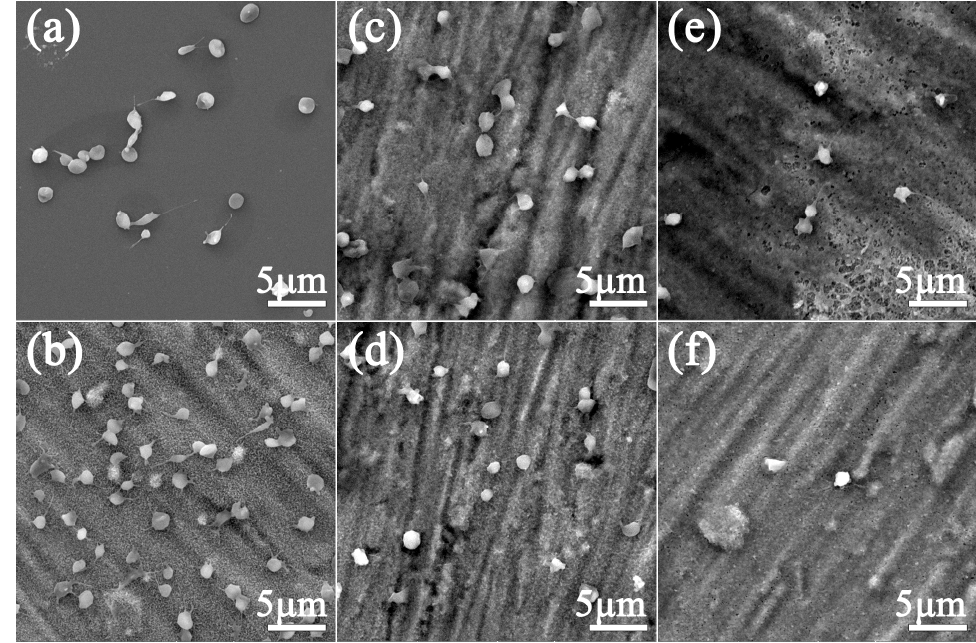
Figure 6. Typical SEM images of platelet adhesion on the surfaces of ( a ) glass, ( b ) TiOH substrate, HA/TC-coated Ti substrates with ( c ) 5 and ( d ) 10 bilayers, and HA/QTCs-coated Ti substrates with ( e ) 5 and ( f ) 10 bilayers.